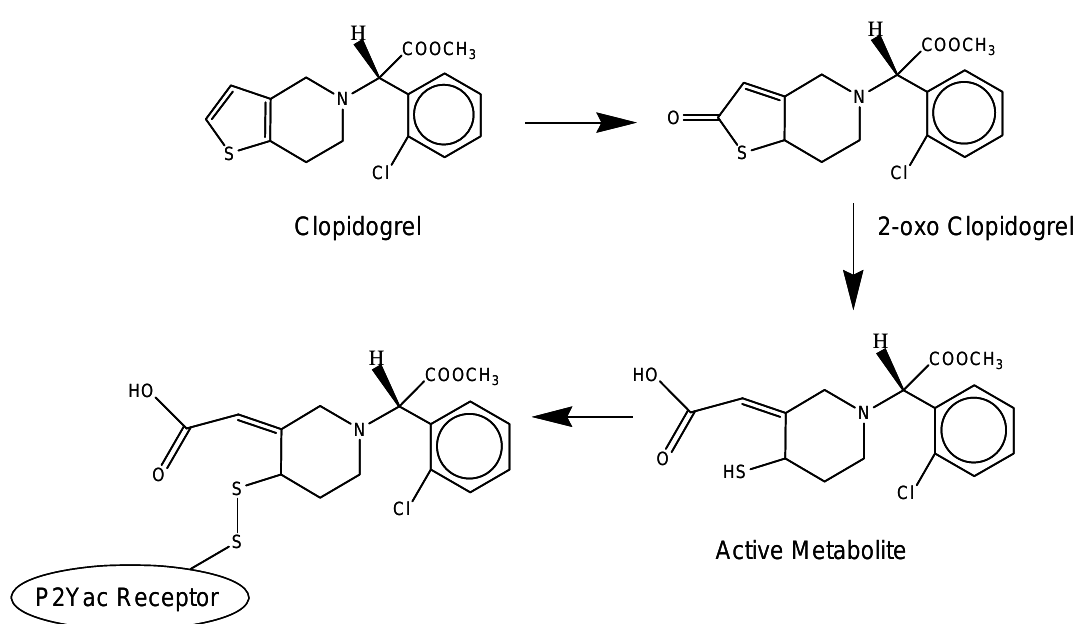
Figure 4. The mechanism of clopidogrel converting to its active metabolite in the liver (adapted from